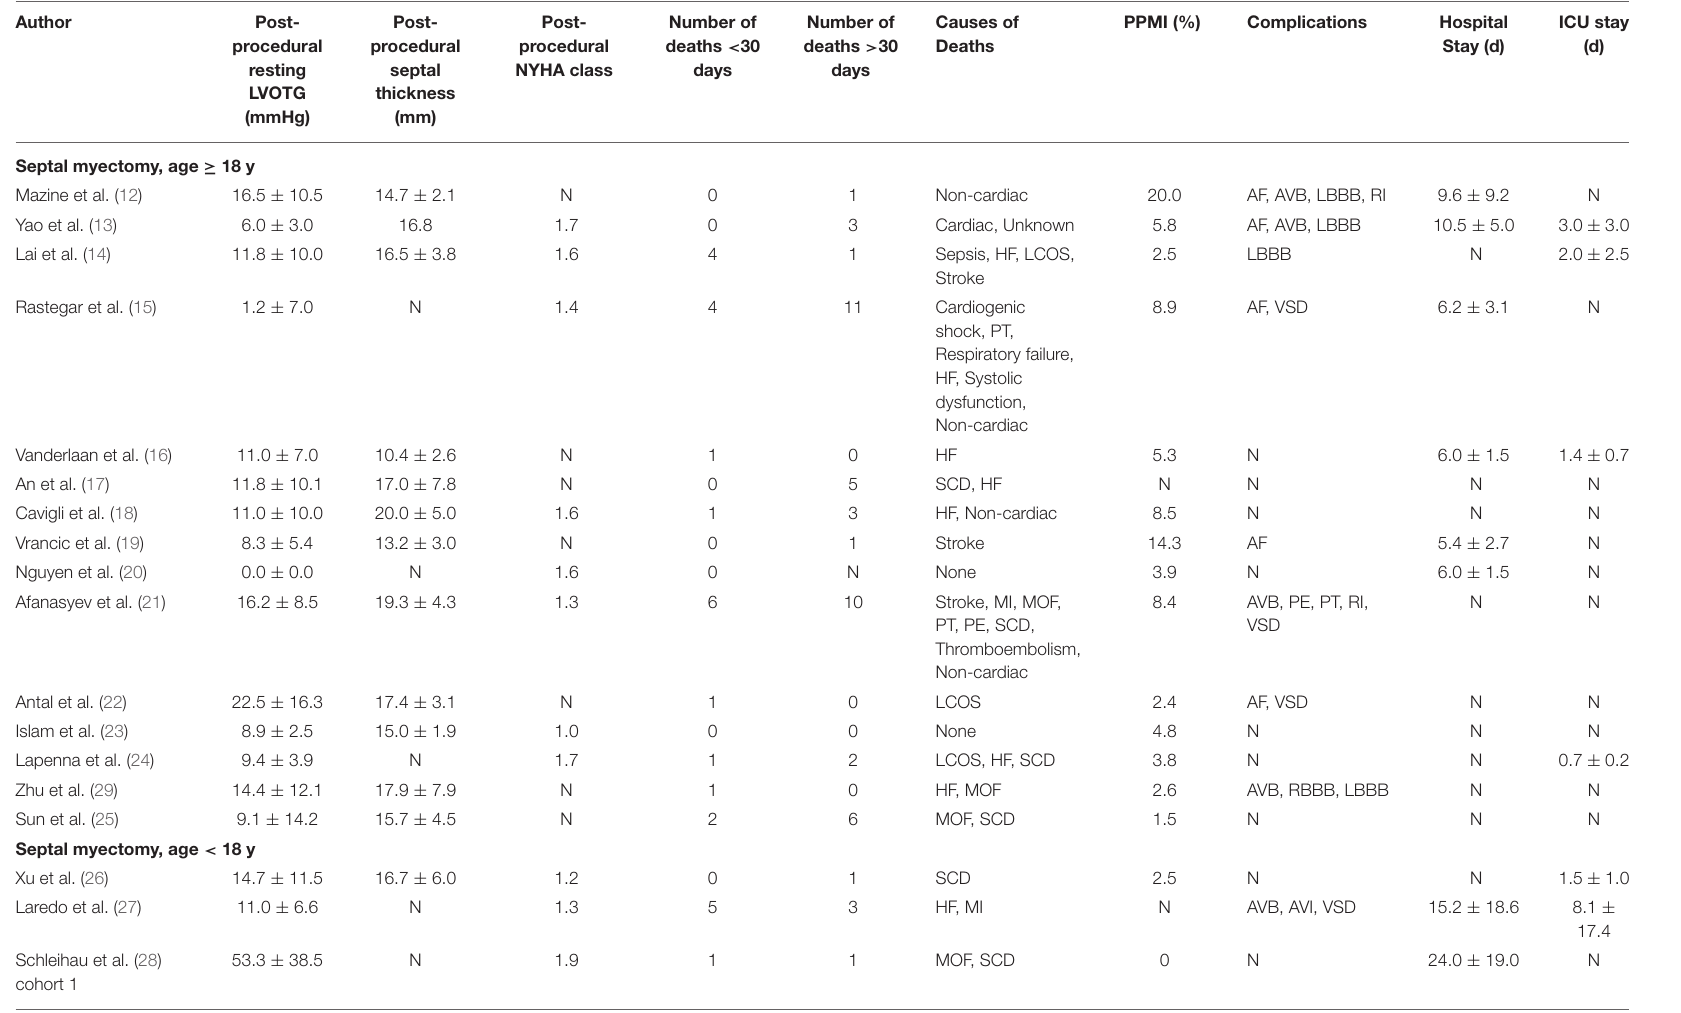
TABLE 3 | Clinical